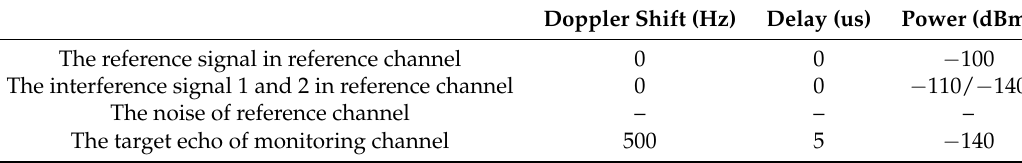
Table 2. Parameter